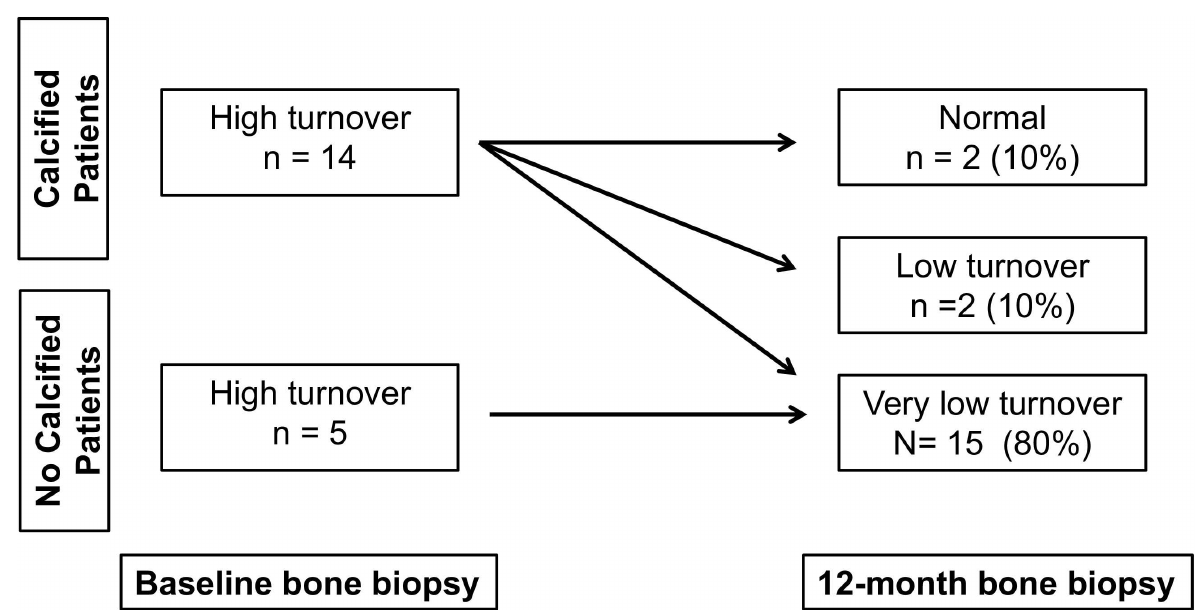
Fig 1. Evolution of bone turnover in the calcified and no calcified patients following PTX.